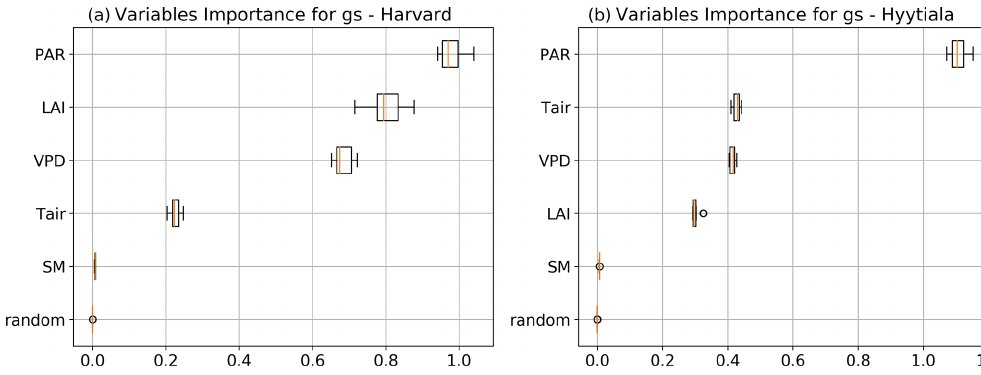
Figure B4. Same as B3 for the stomatal conductance (gs).